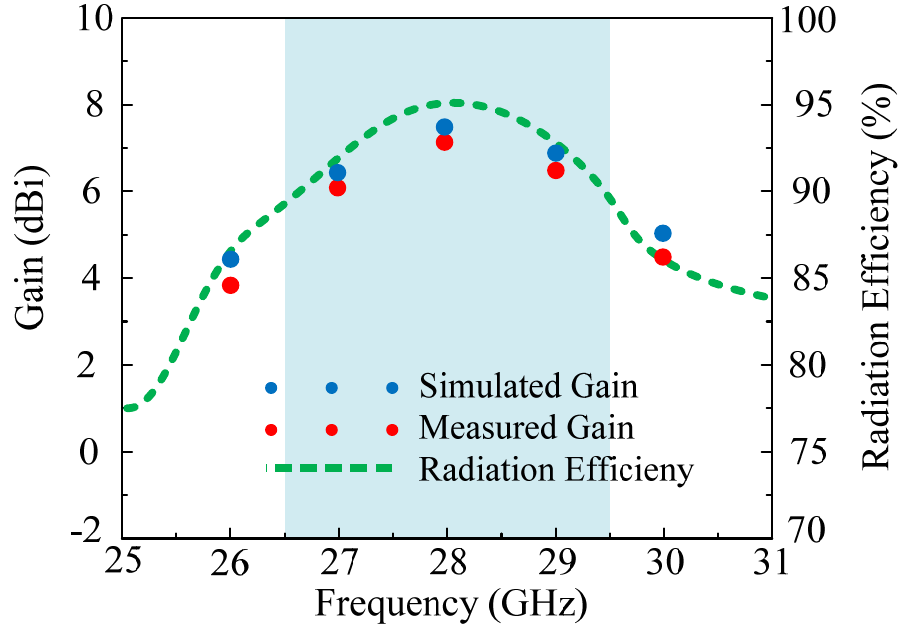
Figure 5. Simulated and measured values of gain and radiation efficiency of proposed single ele- ment antenna. Table 1. Comparison of Proposed work with already published work. Ref.